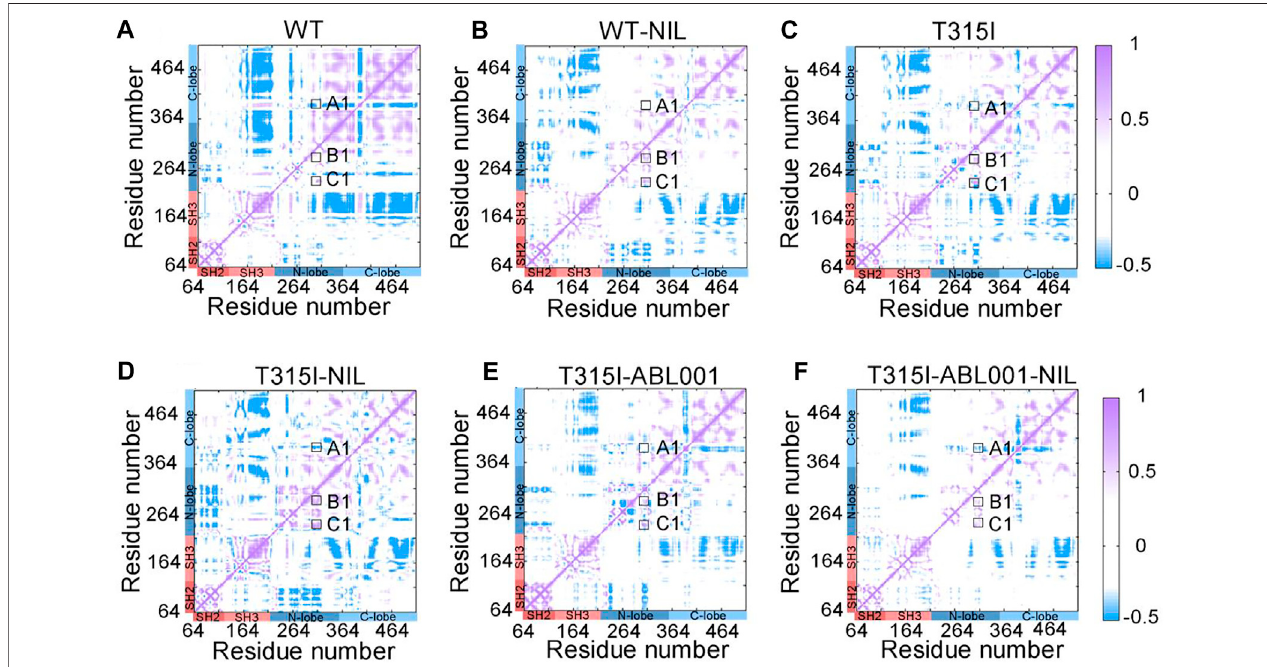
FIGURE 4 | DCCM plots of WT (A) , WT-NIL (B) , T315I (C), T315I-NIL (D) , T315I-ABL001 (E) , and T315I-ABL001-NIL (F) systems. Positive areas (purple) represent correlated motion, while negative areas (blue) stand for anti-correlated motion. Correlation motions with absolute values less than 0.3 are ignored and displayed in